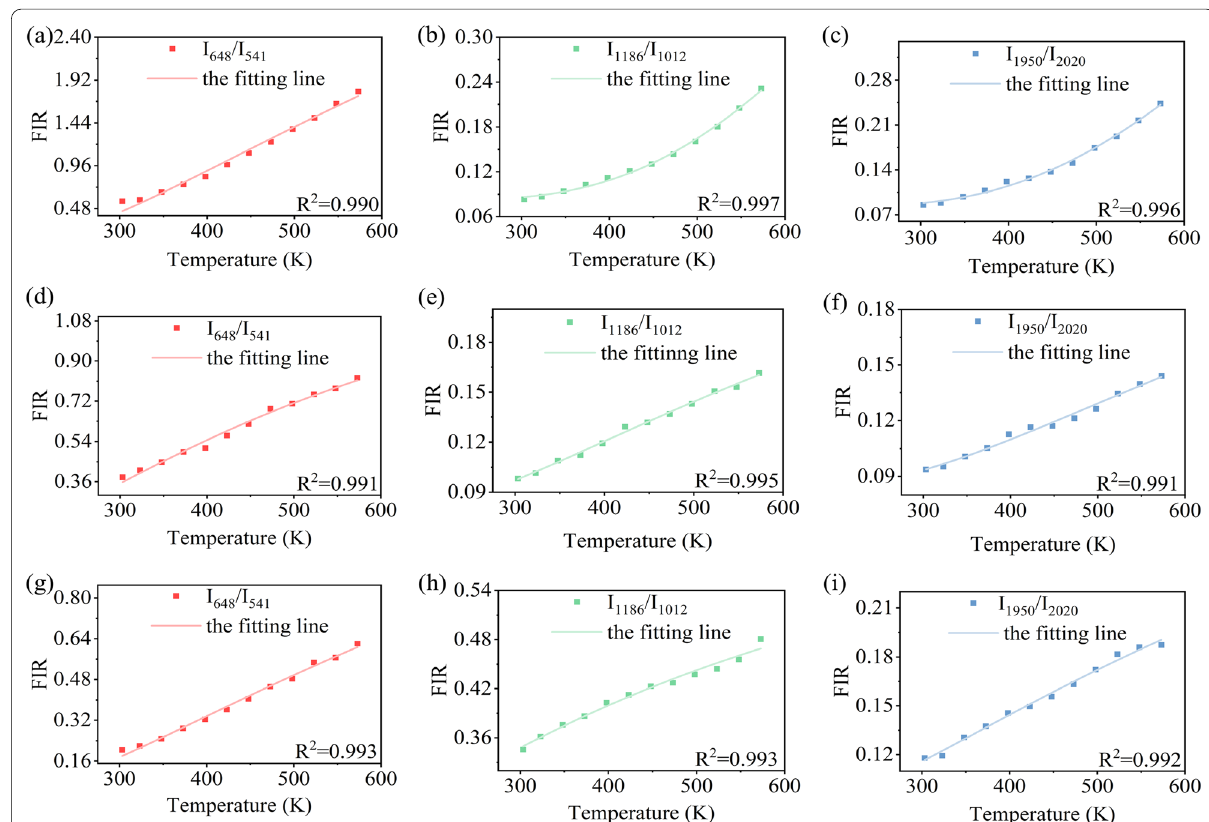
Fig. 7 The experimental data (dot) and fitting curves (line) of different FIRs versus temperature of SrF 2 :Yb 3 + /Ho 3 + (12/0.1 mol%) NCs under the a – c 980 nm, d – f 940 nm and g – i 915 nm excitations,